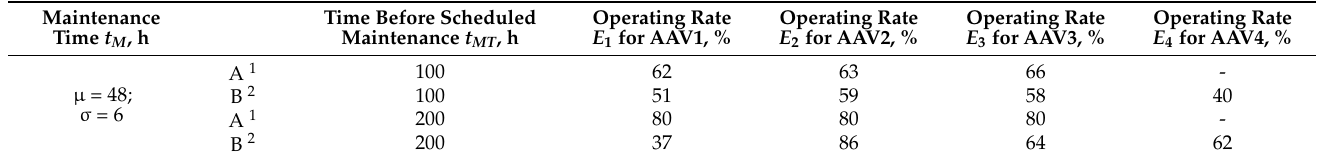
Table 9. AAV reserve efficiency